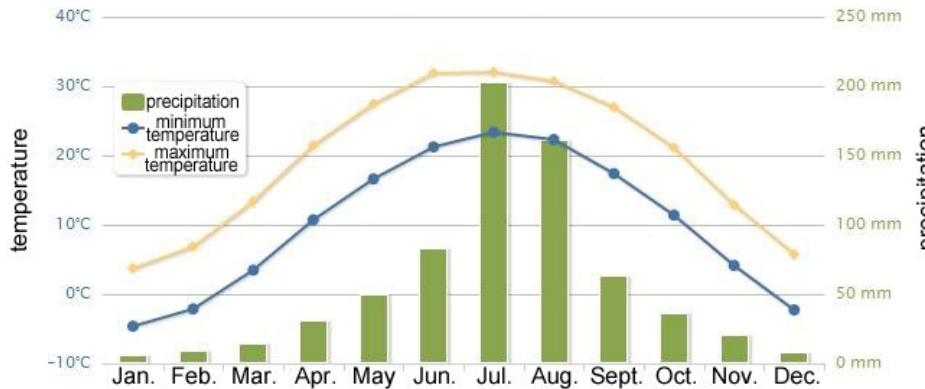
Figure 5. Shandong annual temperature and humidity analysis